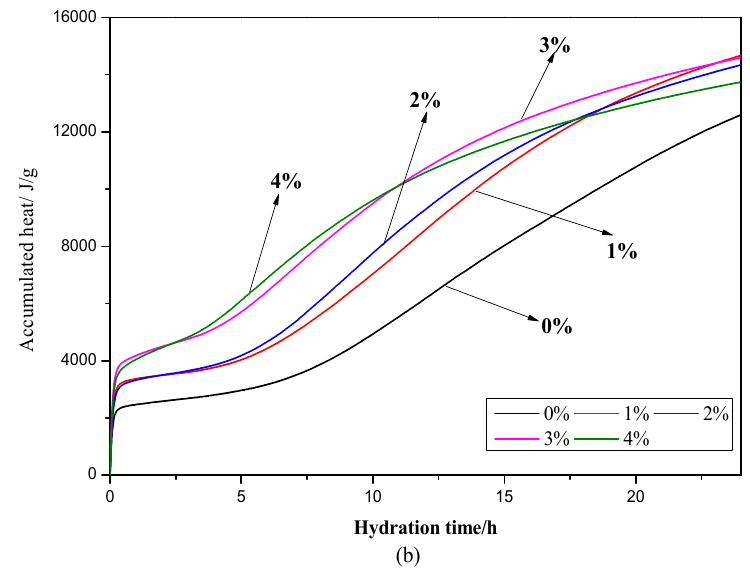
Figure 4. Hydration heat rate ( a ) and accumulated heat ( b ) of the pastes with different contents of Na 2 CO 3.